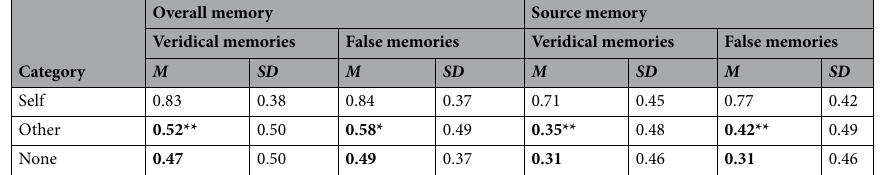
Table 2. Veridical and false memories in Experiment 2. Data indicate mean proportions ( M ) and standard deviations ( SD ) for all "Yes" answers in the recognition memory test (left panel) and for only those "Yes" answers with additional indication of respective source memory (right panel), shown for actually presented words (veridical memories) and for critical lures (false memories) separately for the three word categories (Self, Other, None). Proportion values refer to 25 items for veridical memories and to 5 items for false memories (critical lures). All “Self” means differ significantly from the corresponding means in the other two categories (all p s < 0.001). Critical statistical comparisons (shown in bold) refer to differences in the means between the two categories “Other” and “None”, in which words were not relevant to the own task and therefore only incidentally encoded. * p < 0.05, ** p < 0.01, for difference between “Other” and